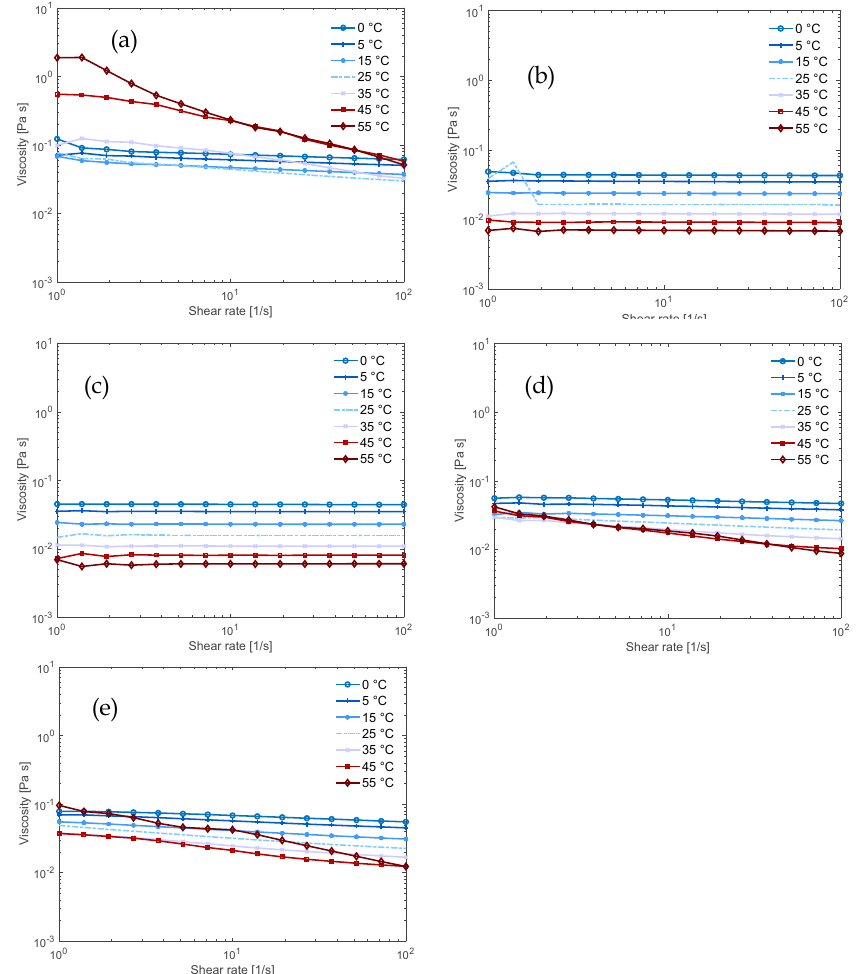
Figure 3. Flow sweeps of 0.36 mol% MCC in 4 mol% base (aq) solution (11:1:266 molar ratio of base:AGU:H2O) in ( a ) NaOH; ( b ) TMAH; ( c ) Triton B; ( d ) 50/50 NaOH/TMAH; ( e ) 50/50 NaOH/Triton B.